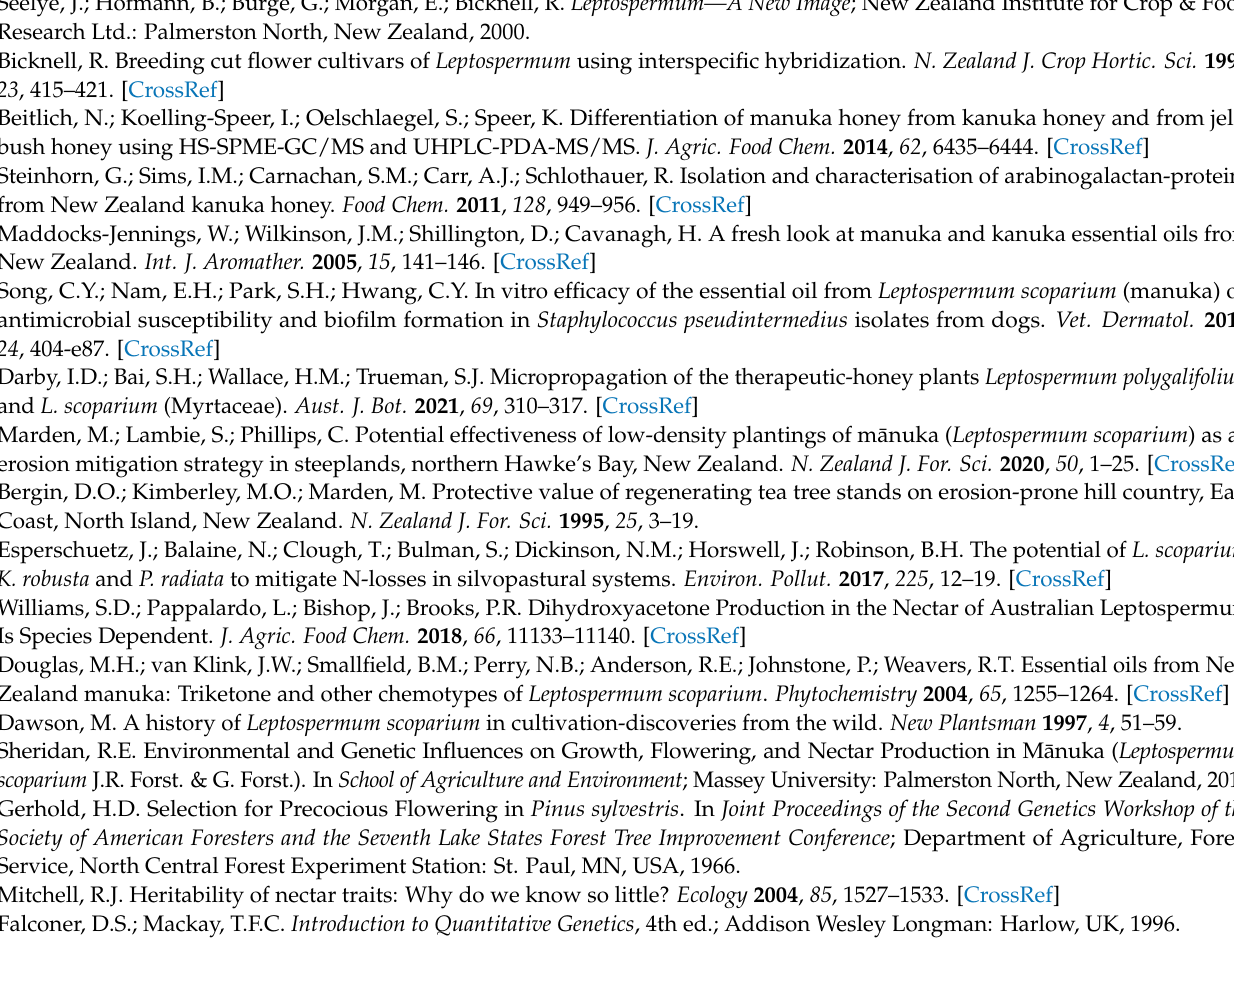
Figure S1. Principal component map showing dimensions PC1 and PC2 for 35 Bioclim variables (see Table S2 for variable codes and names) at the 40 population